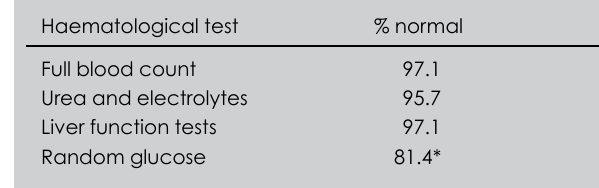
Table II. Haematological test results